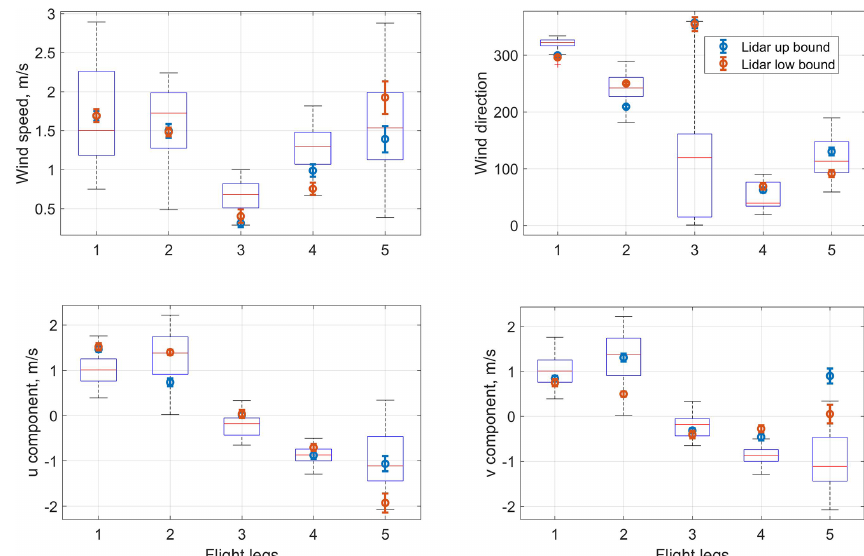
Figure 7. Wind parameters comparison between the AIMMS-30 and Lidar from five “leveled” flight legs at different altitudes on 9 Novem- ber 2021. The average altitudes from flight legs 1 to 5 are 915, 1069, 1221, 1373, 1525, and 1610m. On each box (representing the AIMMS data), the central mark indicates the median, and the bottom and top edges of the box indicate the 25th and 75th percentiles, respectively. The whiskers extend to the most extreme data points not considered outliers. The blue and red circles with the error bar are DL retrieved data.